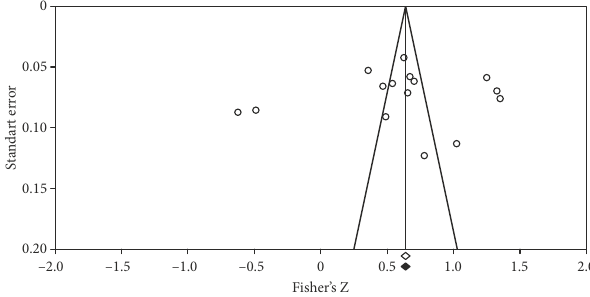
Figure 3. Funnel plot of cost-engineering harmony effect value